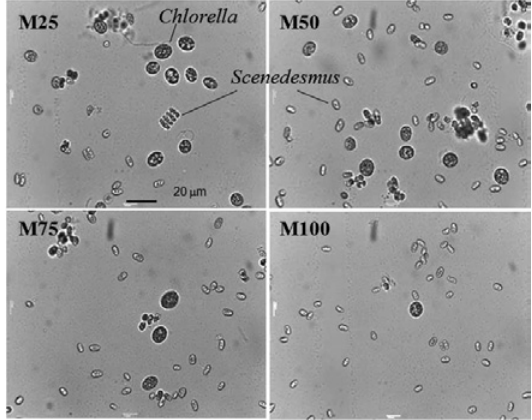
Fig. 4. The mixture of Chlorella and Scenedesmus species in the stationary growth phase at different concentrations of